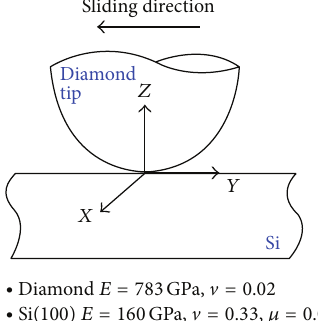
Figure 5: Contact stress analysis using the boundary element